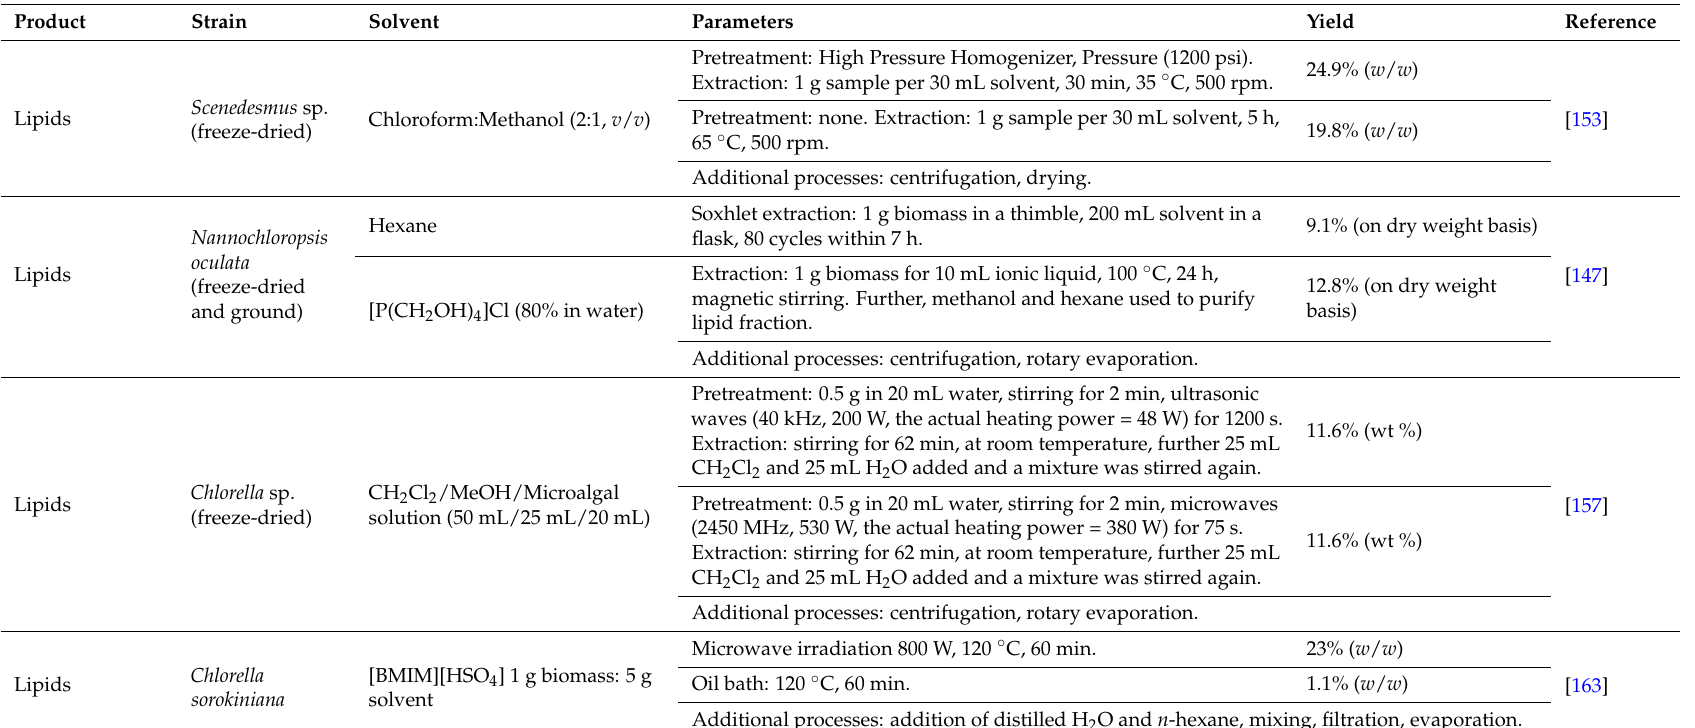
Table 1. Effect of different techniques, process parameters and solvents on lipid extraction yields from microalgal biomass.